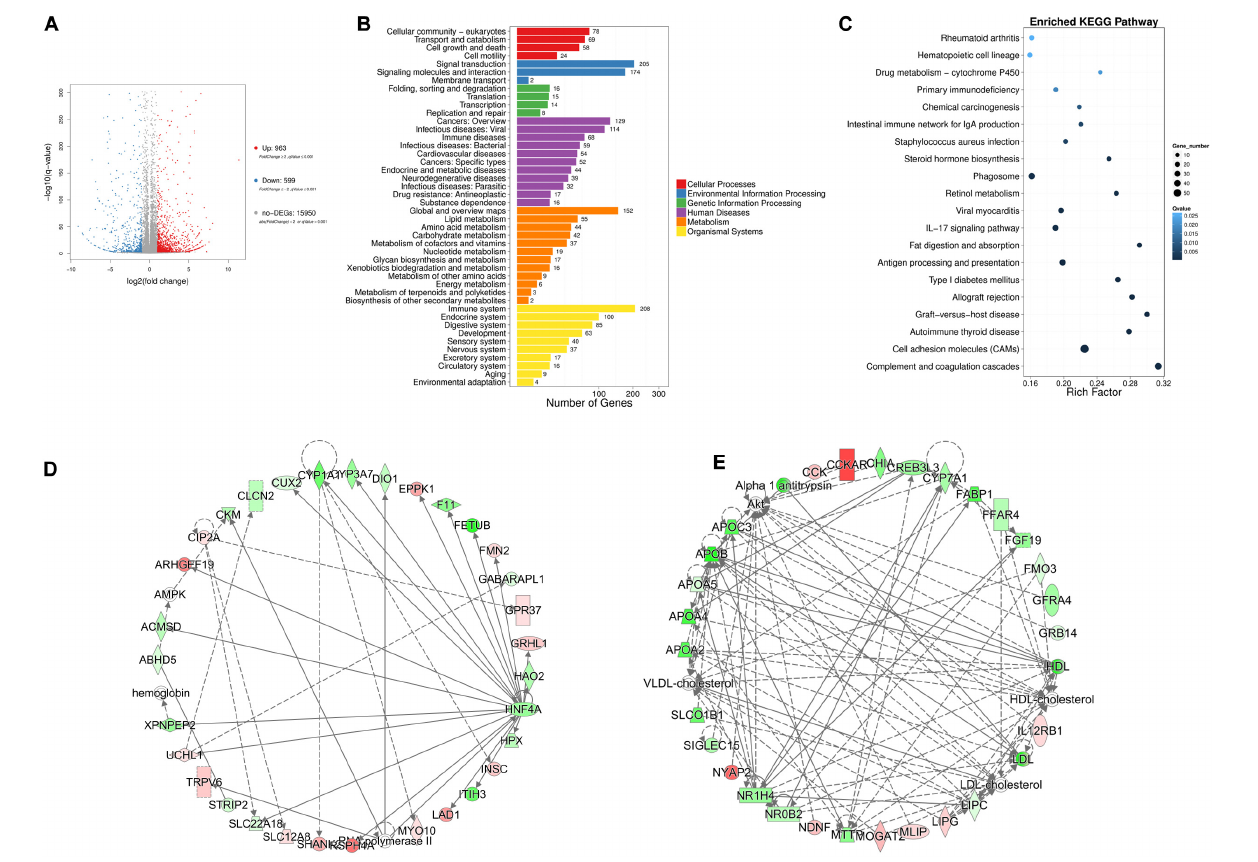
FIGURE 1 | mRNA-seq analysis in chicken abdominal fat tissues between high-fat group and low-fat. (A) Volcano plot for low-fat_VS_high-fat DEGs. (B) The KEGG pathways classification analysis for DEGs. (C) The KEGG pathways enrichment analysis for DEGs. (D,E) The interaction networks for lipid metabolism-related DEGs with IPA enrichment score above 30.